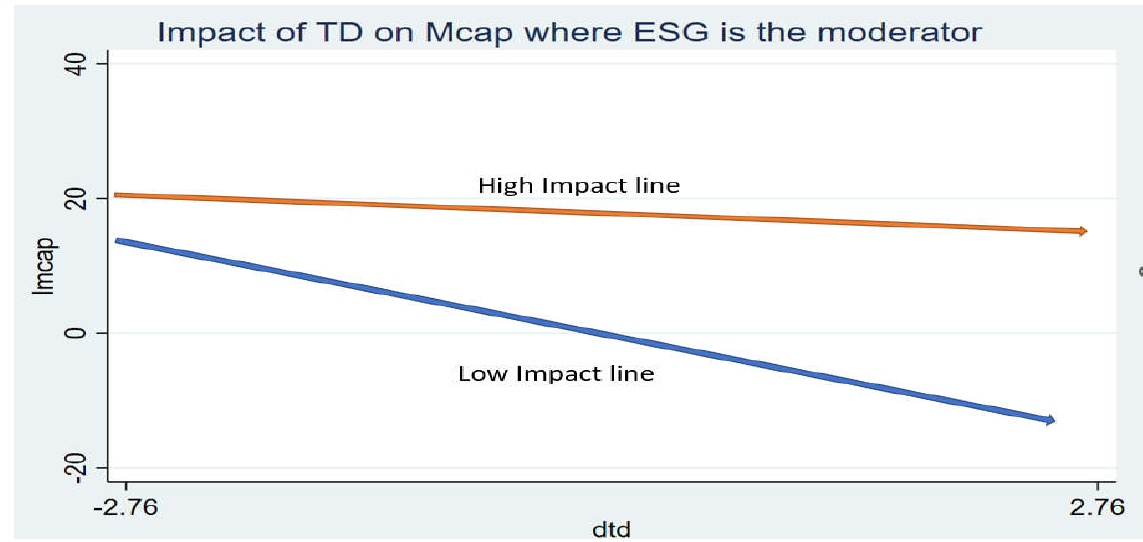
Figure 2. Interaction Graph. Source: Author’s Compilation. Note: Figure 2 elaborates the effect of td on the lmcap of the firms under the influence of moderator esg .